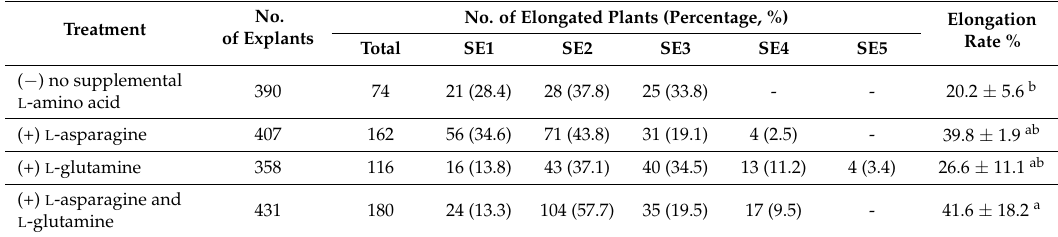
Table 3. No. of elongated shoots at different times and elongation rates in the different treatments.